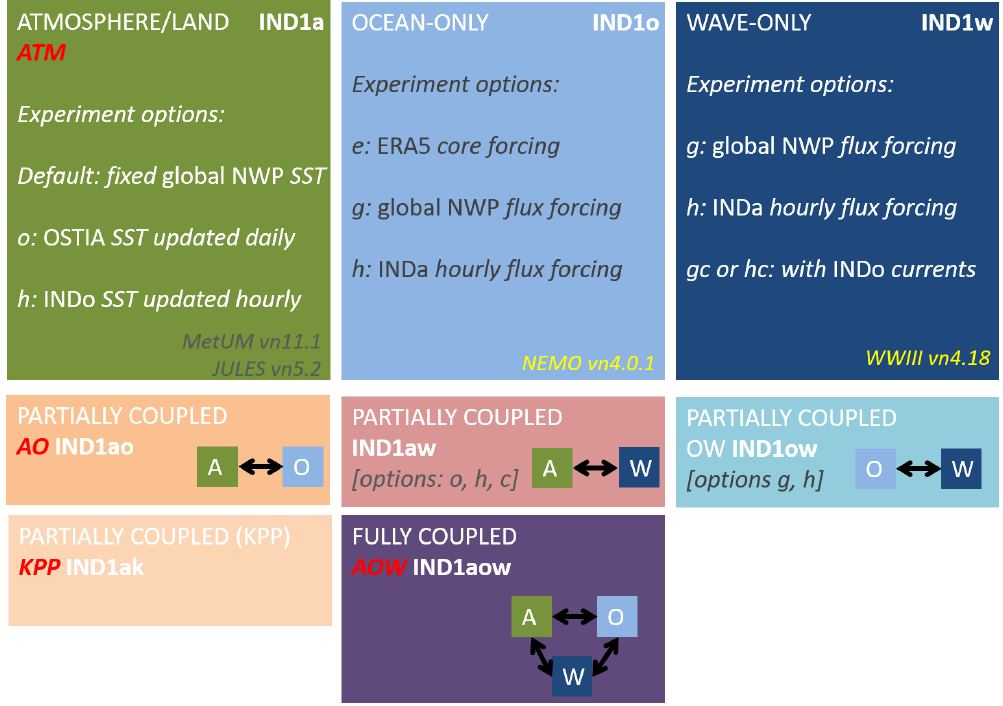
Figure 2. Schematic summary of RCS-IND1 modelling framework configuration, experiment options and naming conventions. Configura- tions highlight with experiment identifiers in red are presented in this